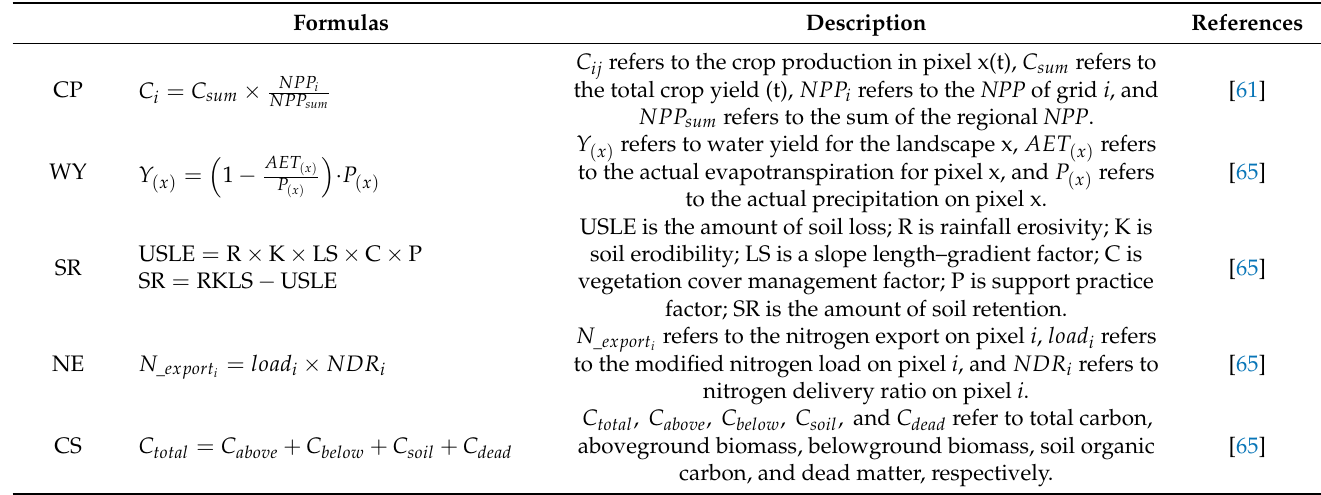
Table 1. Methods for quantifying ecosystem services. (CP, crop production; WY, water yield; SR, soil retention; NE, nitrogen export; CS, carbon